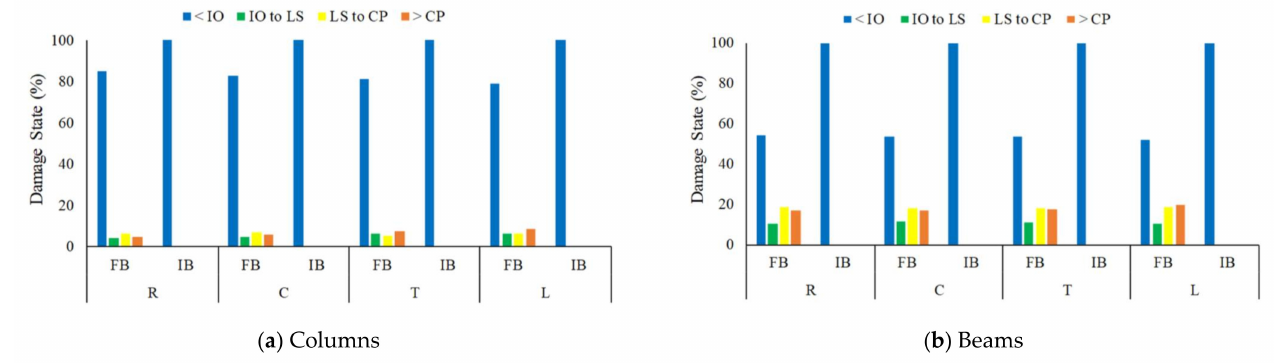
Figure 20. Fiber hinge results for columns and